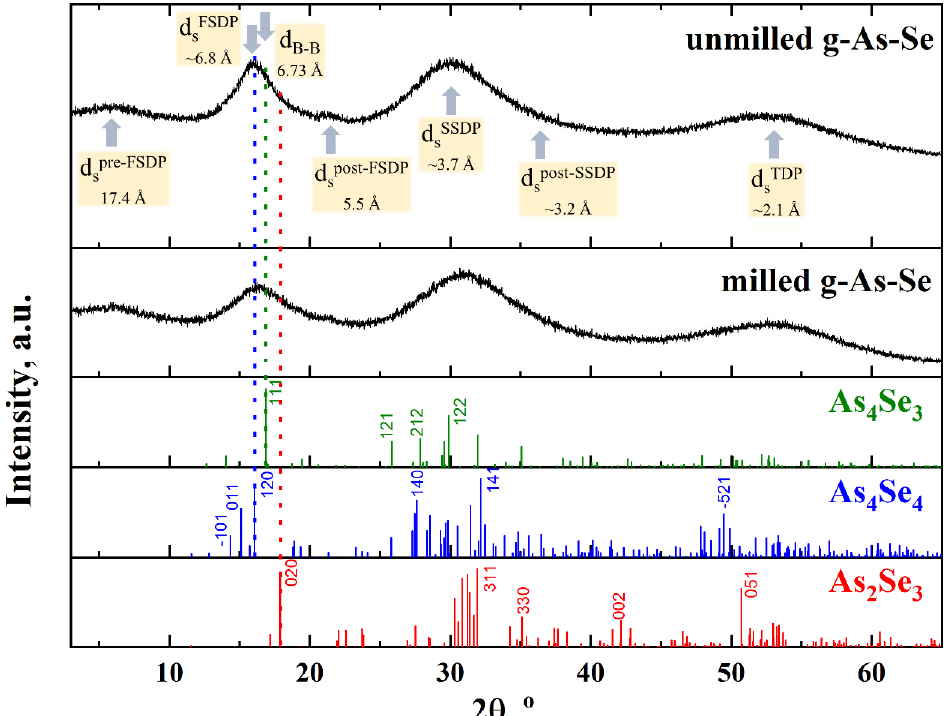
Figure 1. Experimental XRPD patterns of MQ-derived (unmilled) and MM-derived (milled) arsenic monoselenide g-AsSe demonstrating diffuse peak-halos ascribed to pre-FSDP (~6.2 ◦ 2 θ ), FSDP (~16.0 ◦ 2 θ ), post-FSDP (~20.0 ◦ 2 θ ), SSDP (~29.8 ◦ 2 θ ), post-SSDP (~33.9 ◦ 2 θ ), and TDP (~52.6 ◦ 2 θ ). The most prominent inter-atomic correlations d s corresponding to these features and centroid-centroid distance d B-B in the packing of As 4 Se 4 cage-like molecules in the structure of monoclinic As 4 Se 4 are indicated by arrows. Theoretical Bragg-diffraction reflexes of crystalline arsenic selenides of close chemical compositions such as As 4 Se 4 , As 4 Se 3 , and As 2 Se 3 are given below for comparison (the XRPD patterns of g-AsSe are reconstructed from [13]).